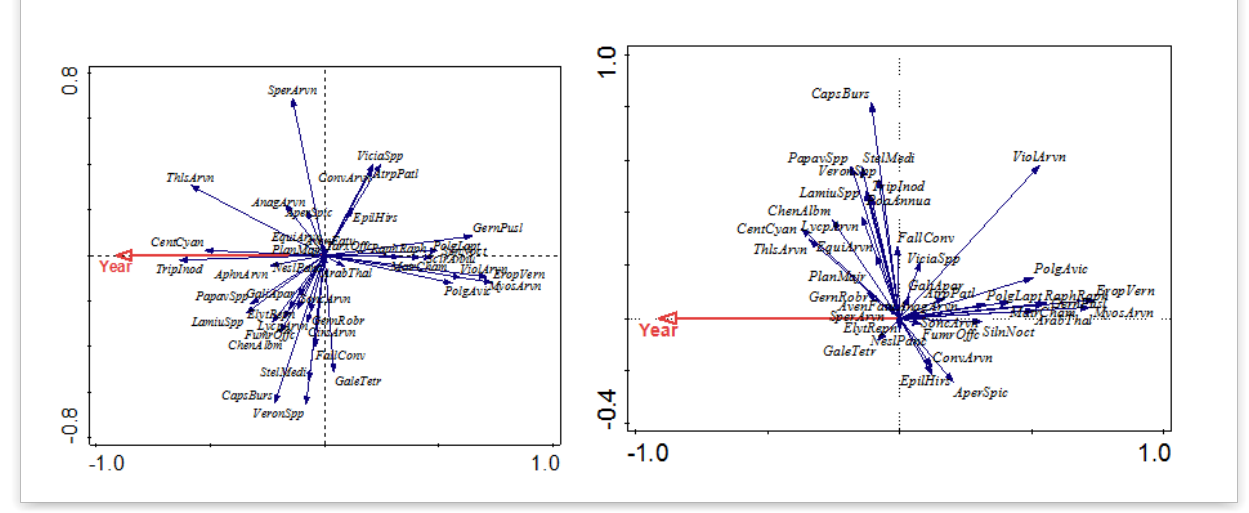
Figure 3. Temporal trends in species composition in Pernolec in multi-crop rotation. Ordination diagrams of partial Redundancy Analysis (RDA) with untreated plots ( right ) and targeted treatment with herbicide combination ( left ). Year is the explanatory variable and crop type is the covariate; species with low weight are not shown.